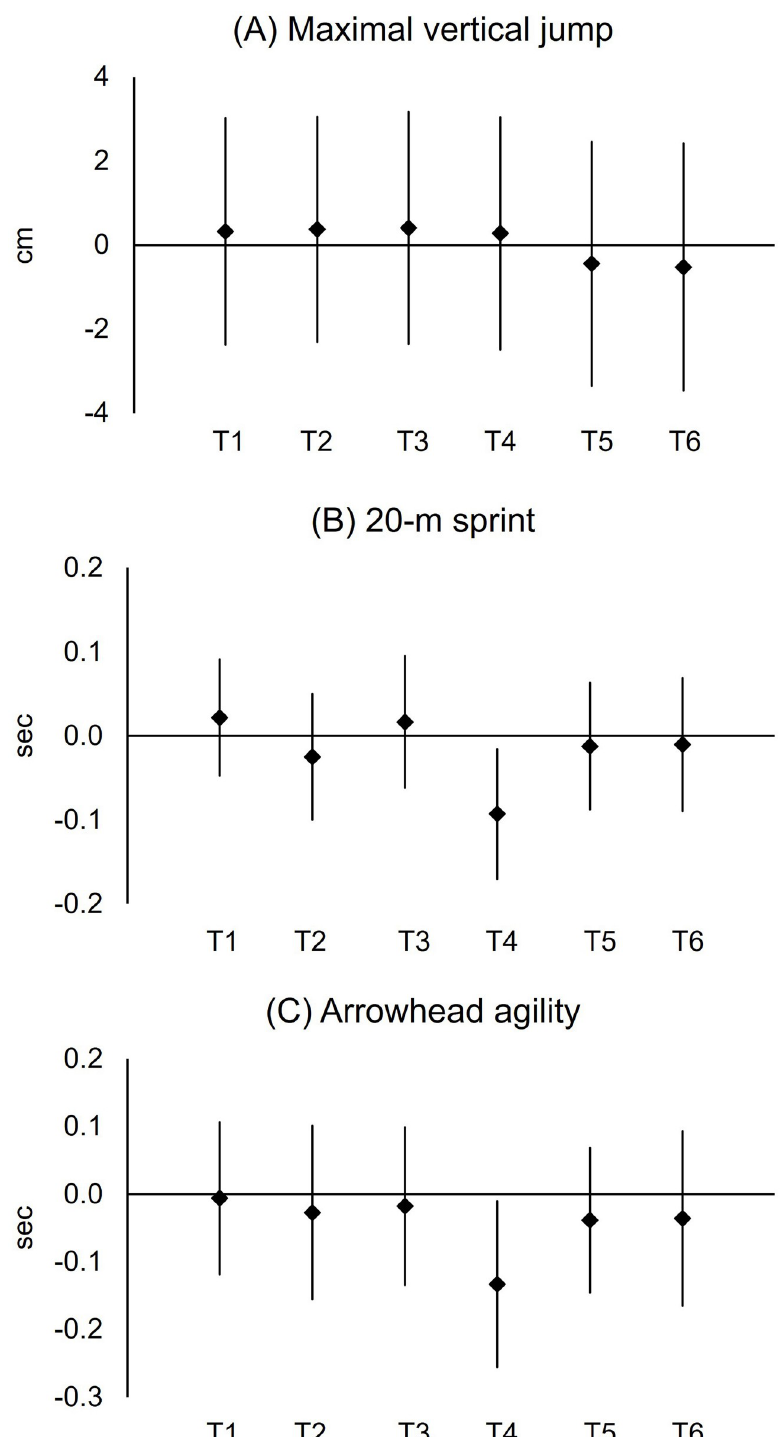
Fig 6. The 95% confidence intervals for difference in mean (maximal vertical jump height: A; 20-m sprint time: B; Arrowhead agility test time: C).